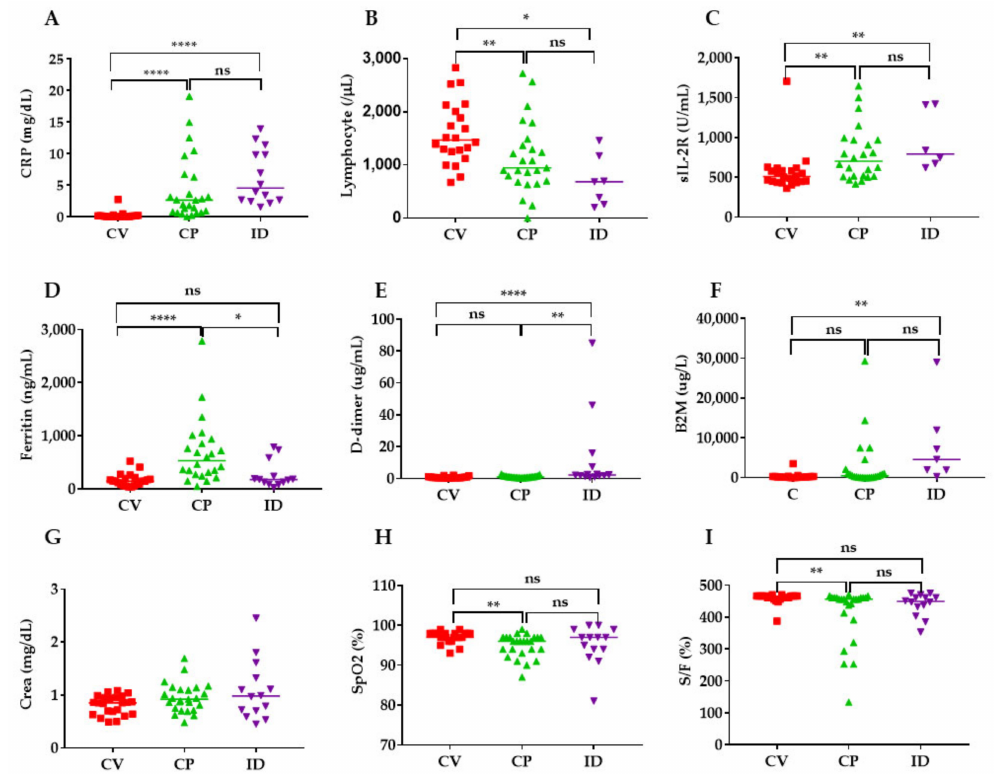
Figure 3. Levels of inflammatory, coagulation, kidney and respiratory indicators in COVID-19 patients (CV, CP) and patients with bacterial infection (ID). Only those with data are shown in the figure. CRP ( A ), Lymphocyte number ( B ), sIL-2R; soluble IL-2 receptor α ( C ), Ferritin ( D ), D-dimer; d-dimer ( E ), B2M; urinary β 2 -microglobulin ( F ), Crea; creatinine ( G ), SpO 2 ; peripheral capillary oxygen saturation ( H ), S/F; SpO 2 /FiO 2 ratio ( I ). CRP, ferritin, and creatinine were measured in plasma and d-dimer was measured in serum. **** p < 0.0001, ** p < 0.01, * p < 0.05; ns; not